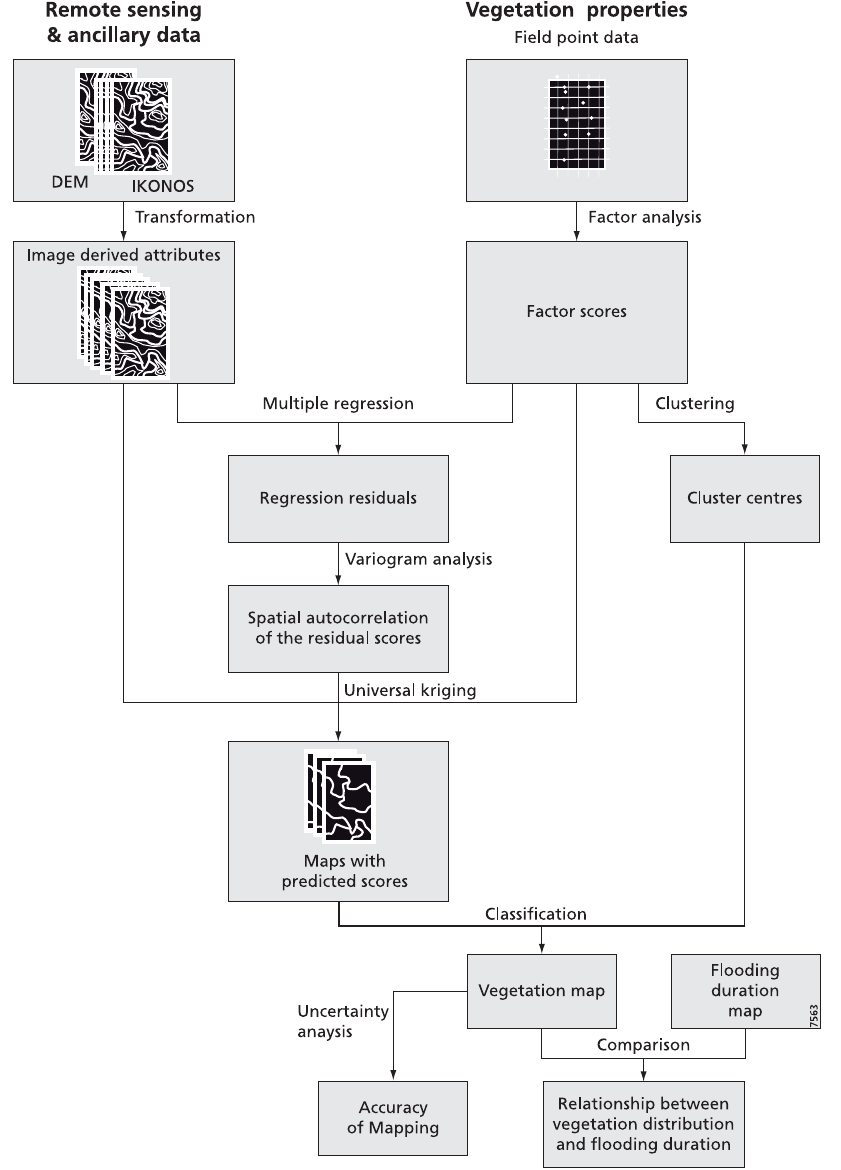
Fig. 2. Flow diagram describing the procedural steps in the analysis of the